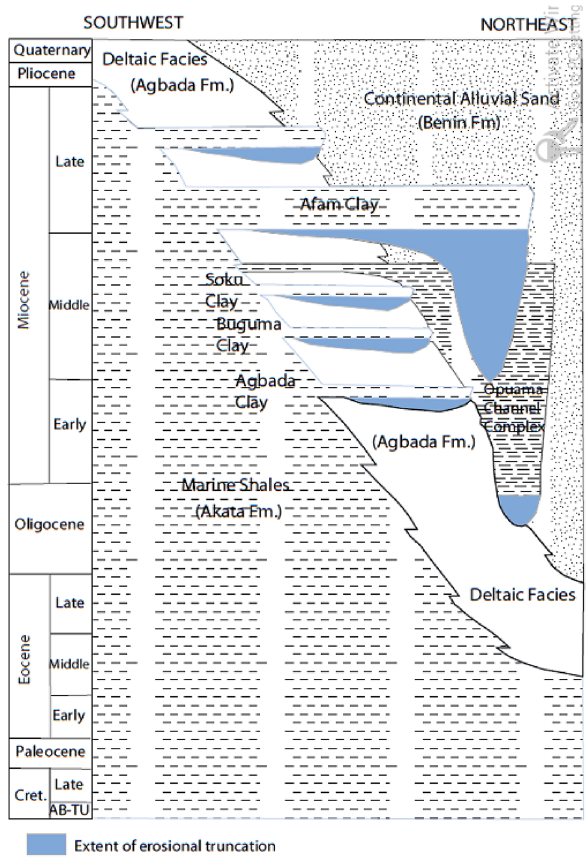
Fig. 1 Stratigraphic columns showing the three Formations of the Niger Delta Modified from Doust and Omatsola (1990)